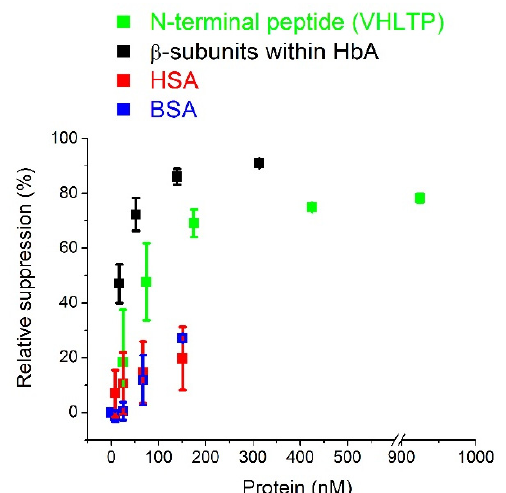
Figure 1. SWV responses of the hierarchical MIP recorded in a PBS solution at a pH of 7.4, con- taining 5 mM ferri/ferrocyanide and 10 mM KCl after electrochemical template removal (E-TR, black trace and after HbA rebinding using different protein concentrations (color code enclosed).